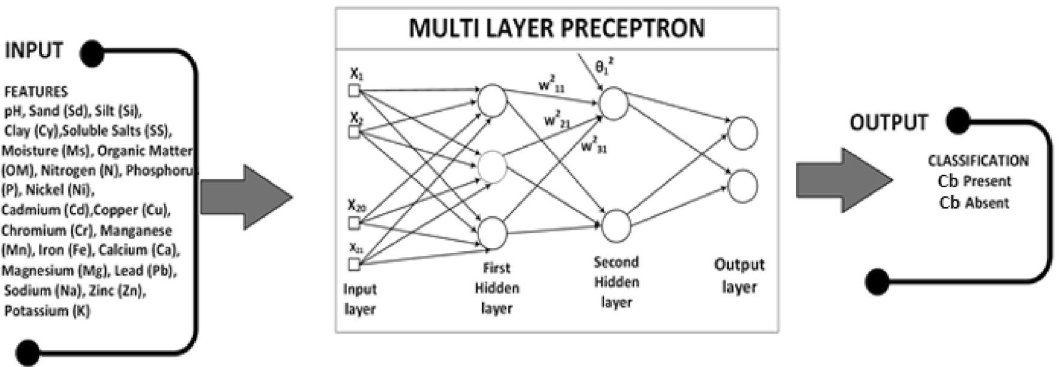
Figure 2. MLP model with inputs { X 1, . . . , X 21 } , two outputs and two hidden layers with three and two hidden units in each layer,